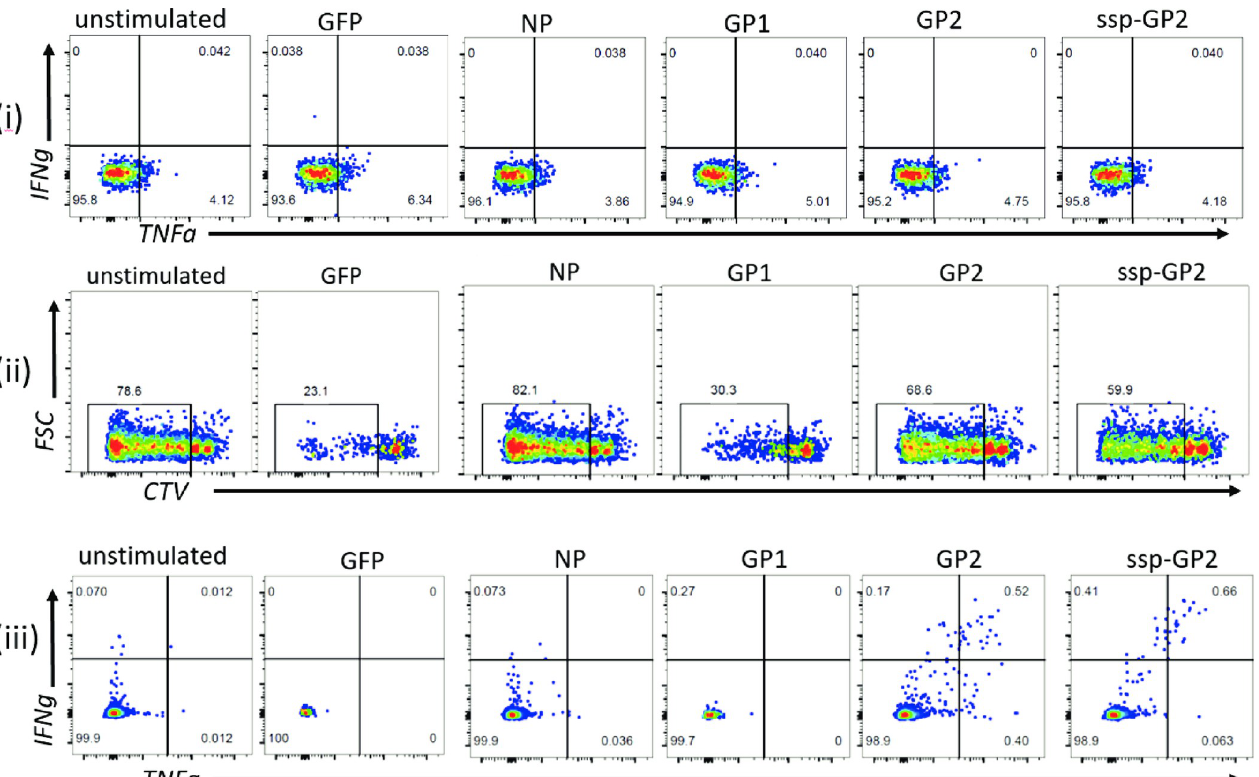
Fig 2. (i) A LF survivor with a negative LASV-specific T cell response to overnight stimulation with different antigens, as denoted above each plot. The same survivor’s proliferated CD8 + T cells (ii) have a positive LASV-specific response (iii) to a prolonged stimulation 10-day proliferation